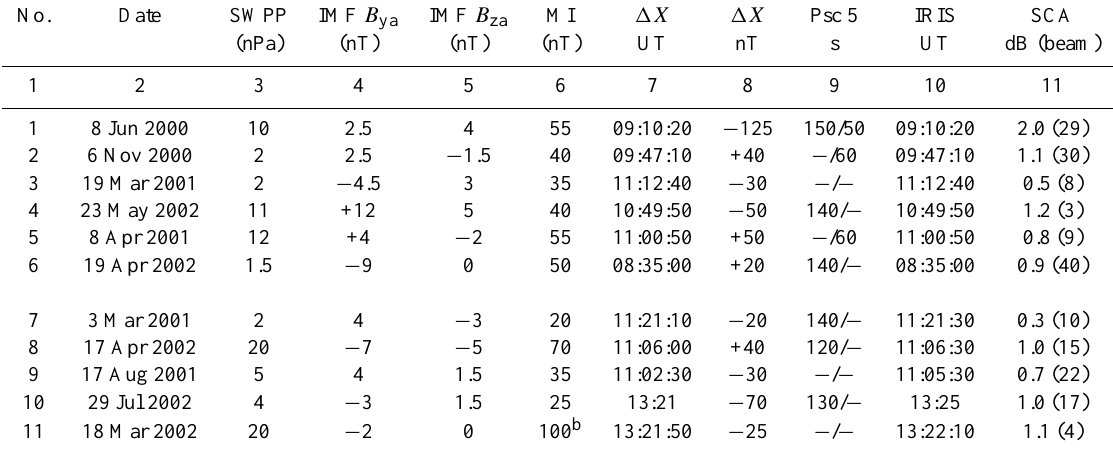
Table 1. Characteristics of SWPPs in space and associated magnetic and riometric disturbances on the ground.